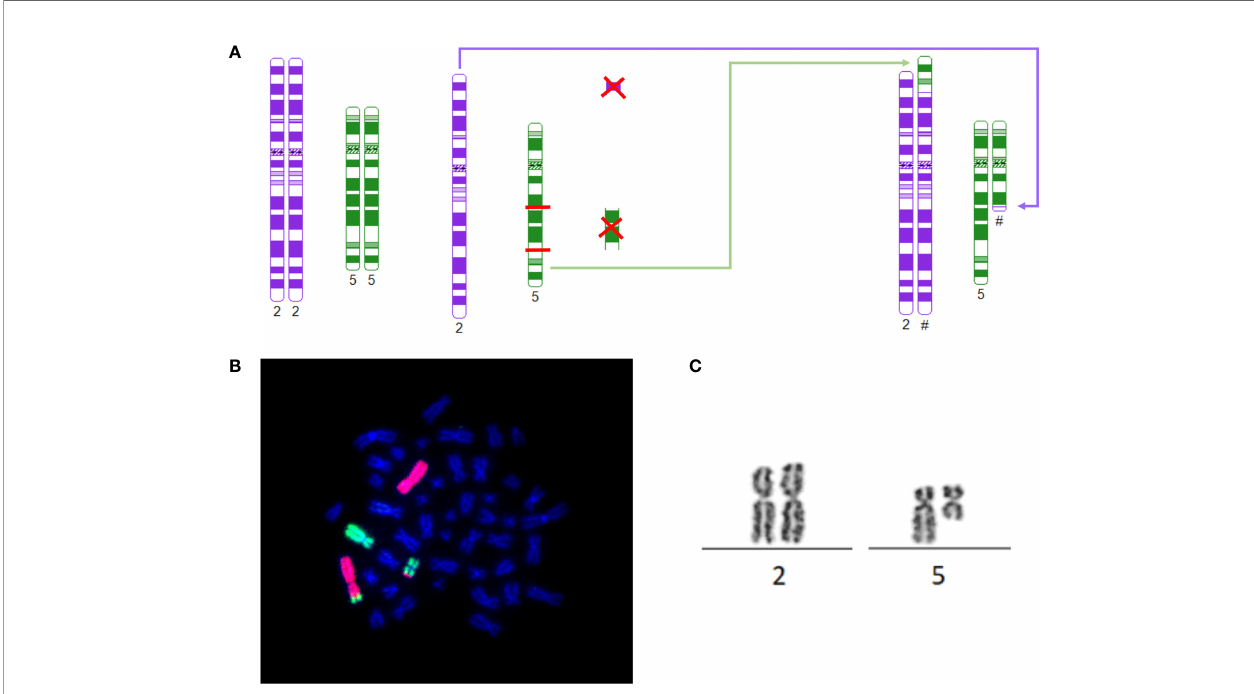
FIGURE 1 | (A) Schematic depiction of breaking points, rearrangement and derivates of 46, XX, der(2)t(2;5)(p23;q31), der(5)t(2;5)(p25;q15)[21]: The model was constructed using http://www.cydas.org/OnlineAnalysis/ (9). (B) 46, XX, der(2)t(2;5)(p23;q31), der(5)t(2;5)(p25;q15)[21]: Whole chromosome painting of case 1 with karyotype: 46, XX, der(2)t(2;5)(p23;q31), der(5)t(2;5)(p25;q15). Chromosome 2 in red, chromosome 5 in green. (C) t(2;5): Part of the karyogram of case 1 depicting t (2;5) as part of 46, XX,